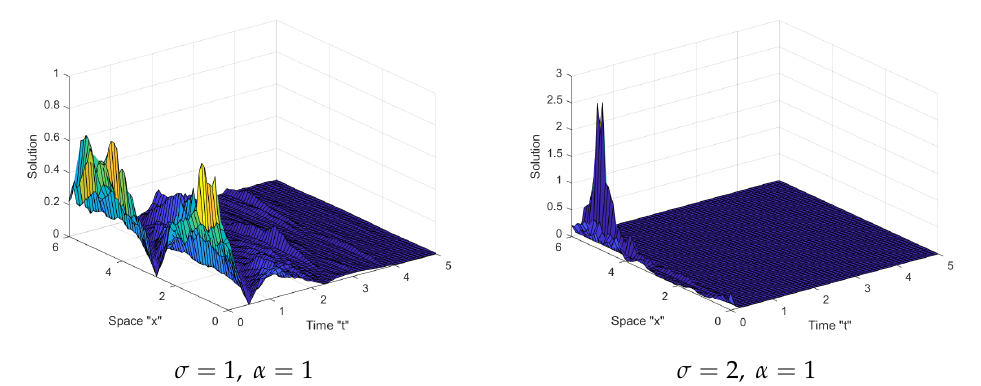
Figure 2. Three-dimensional plots of Equation (12) with α = 0.5.